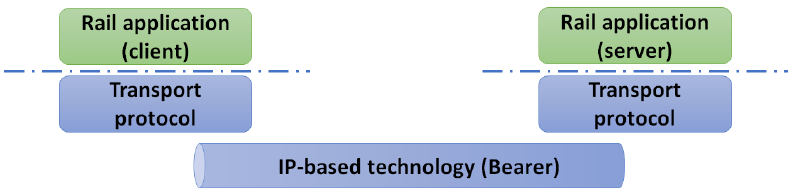
Figure 1. Separation of the communication technology (or bearer) with the rail application.